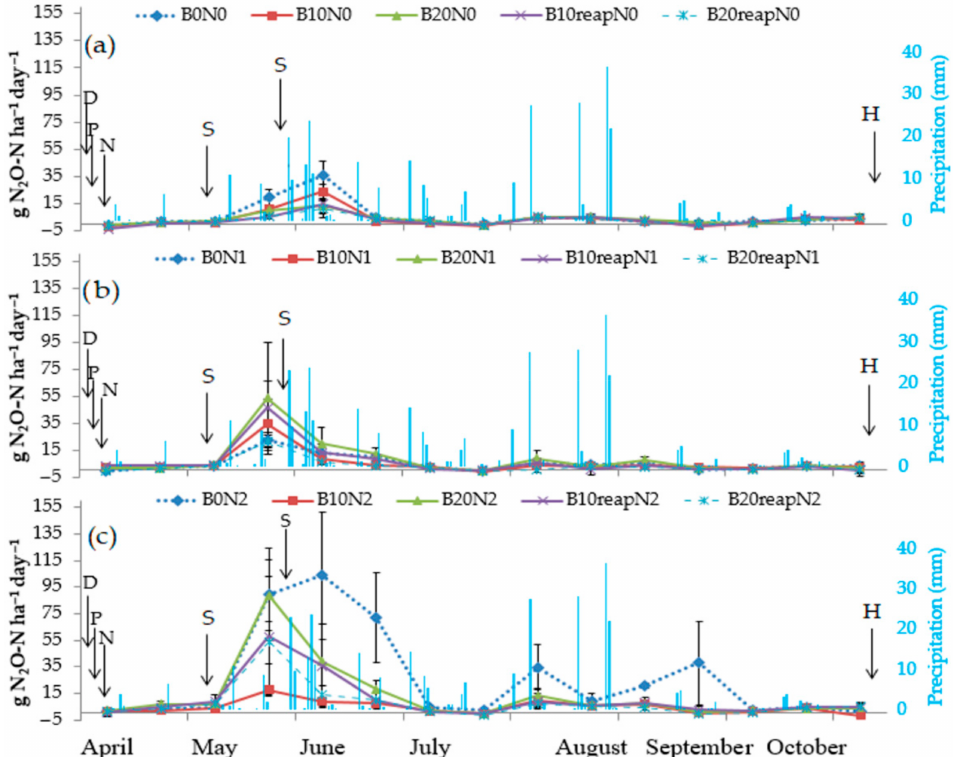
Figure 2. Fluxes of N 2 O from unfertilized soil N0 ( a ), fertilized soil N1 ( b ), and fertilized soil N2 ( c ), with or without the biochar, including precipitation. Error bars denote the standard error of the mean ( n = 3). D—disking; P—planting of maize; N—nitrogen fertilizer application; S—spray herbicide application; H—harvesting